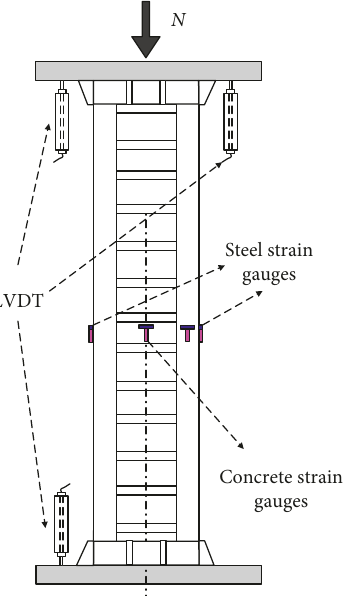
Figure 6: Layout of the measuring points.